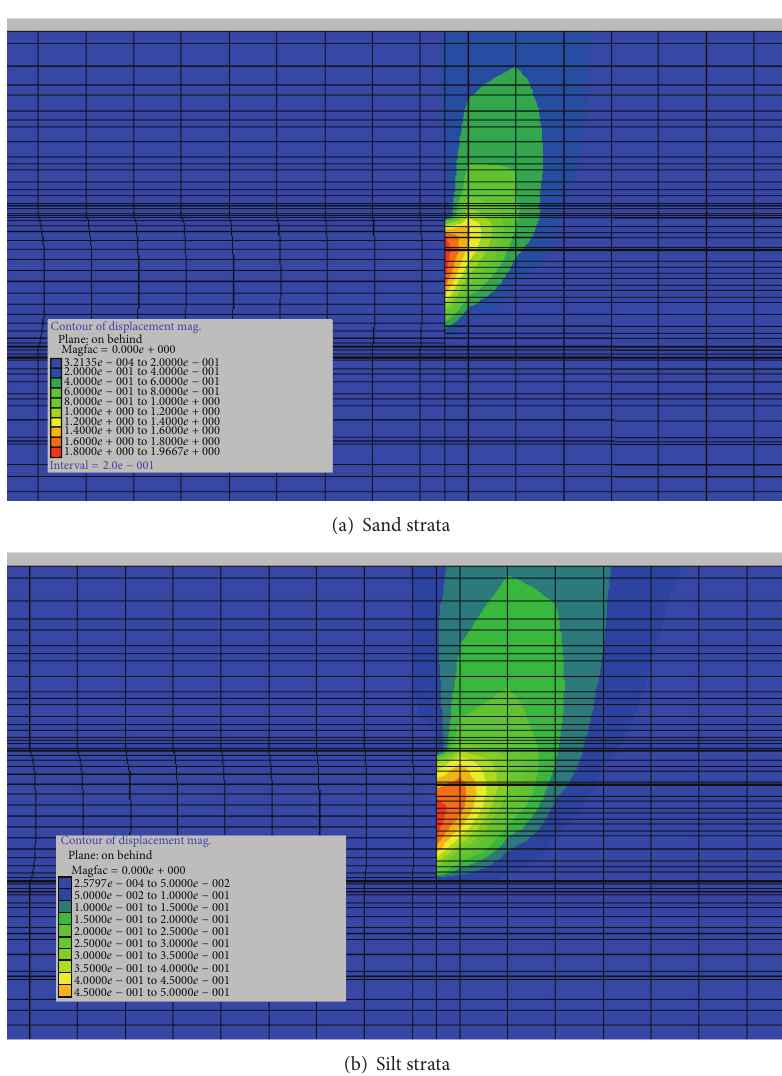
Figure 8: Longitudinal section failure form of the tunnel